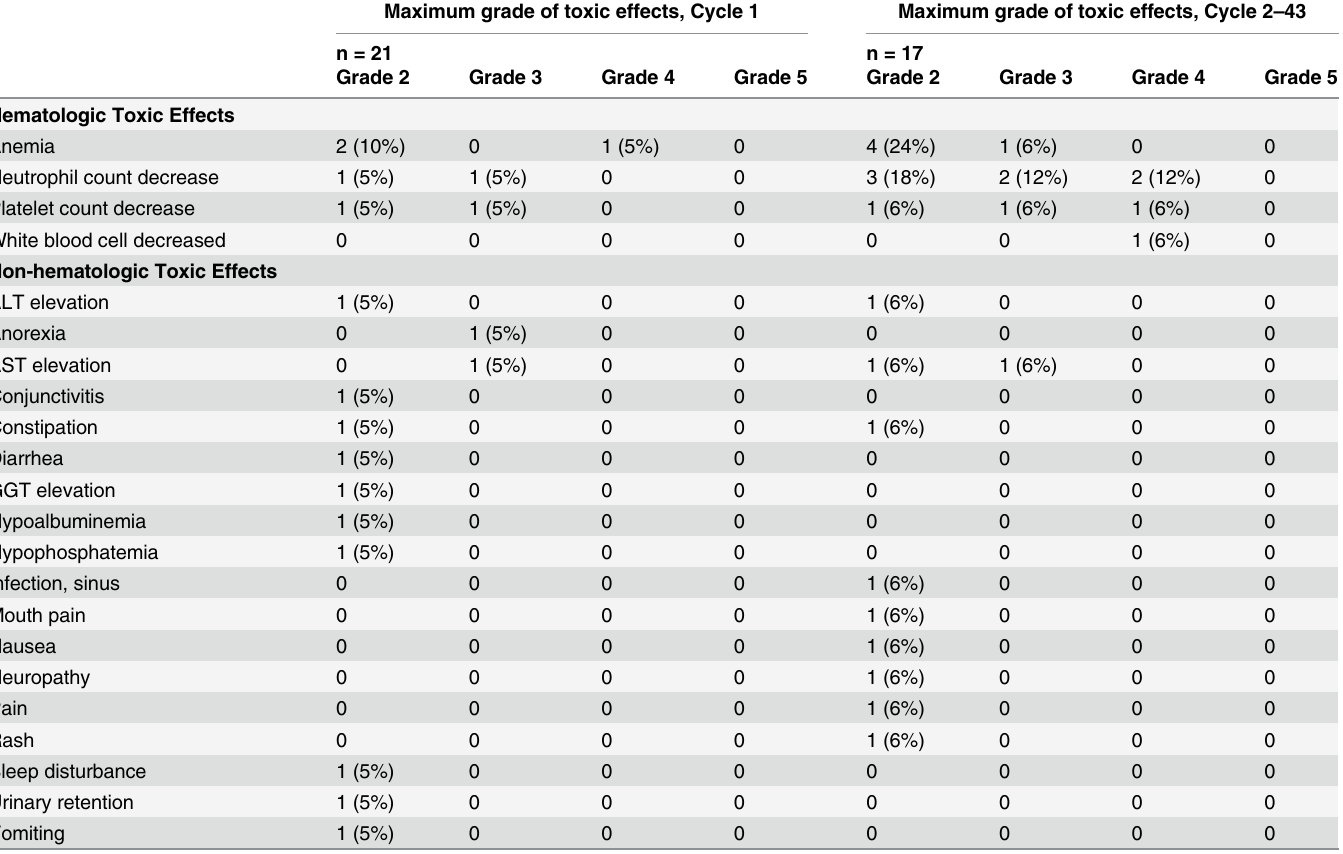
Table 2. Study Safety Data: Toxicity of Oral DFMO and